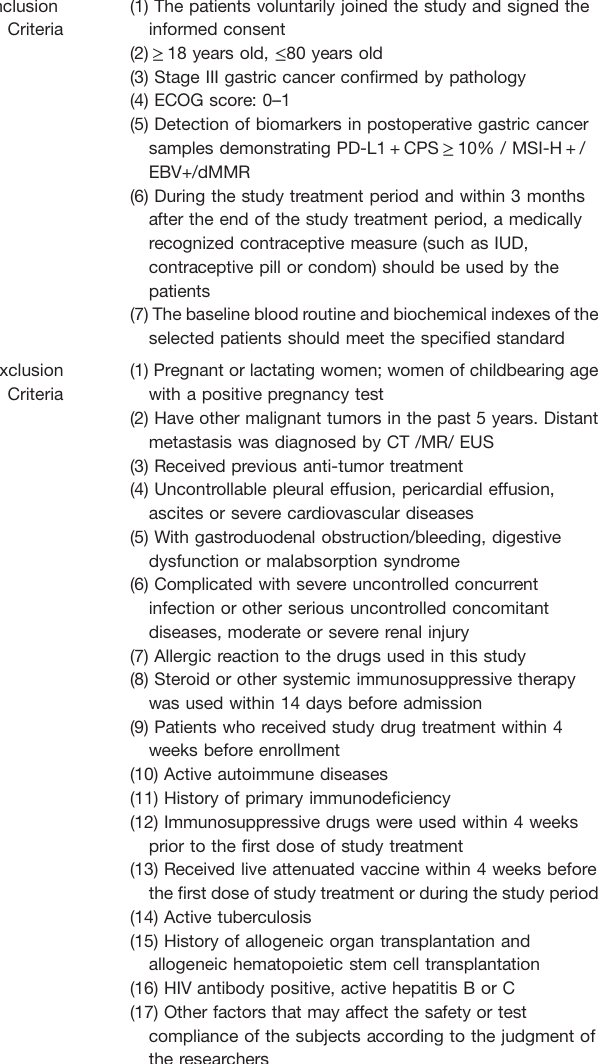
TABLE 1 | Inclusion and exclusion